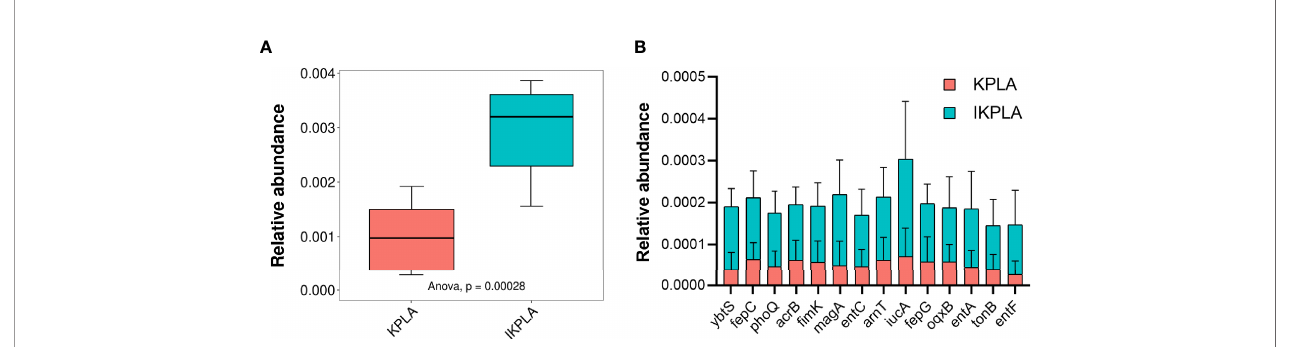
FIGURE 6 | The composition of pathogenic genes in KPLA and IKPLA groups. (A) The relative abundance of PHI genes of K. pneumonia in the KPLA and IKPLA groups. (B) 14 pathogenic genes with signi fi cant differences in abundance were identi fi ed between the two groups, including ybtS, fepC, phoQ, acrB, fi mK, magA, entC, arnT, iucA, fepG, oqxB, entA, tonB, and entF (p